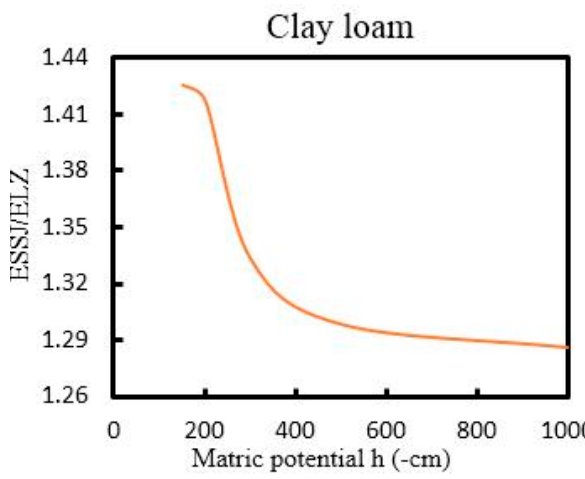
Figure 4. The ratio between Sadeghi’s solution (denoted as E SSJ where SSJ represents the first letters of last names of three authors of Sadeghi et al. [18]) and our solution of Equations (18)–(20) (denoted as E LZ , where LZ represents the first letters of last names of this paper) for clay loam and 100 cm depth of water table.